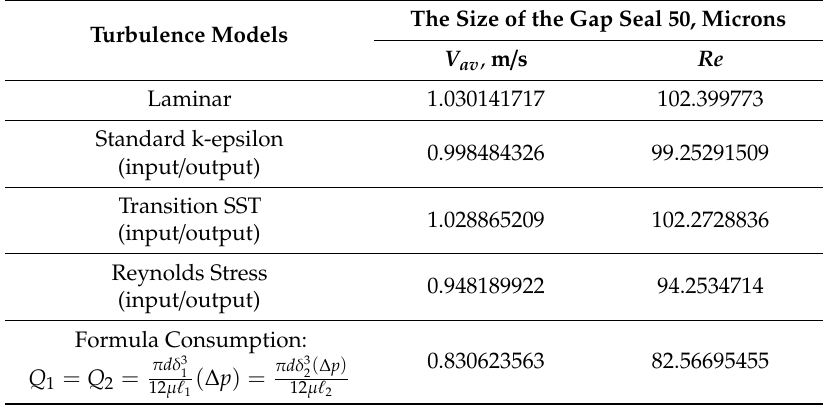
Table 5. Values of average velocities and Reynolds numbers for fluid flow in a step-type gap seals in the forward direction determined by different flow models.